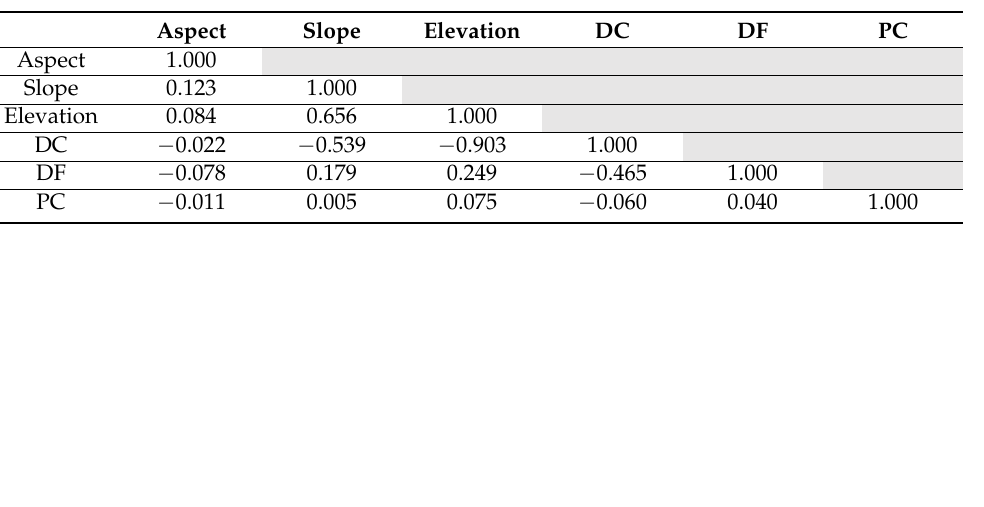
Figure 6. Spatial distribution of r 2 values ( A ) and p -values ( B ) from linear-log regression fitting. Note the color bar inversion in ( B ).